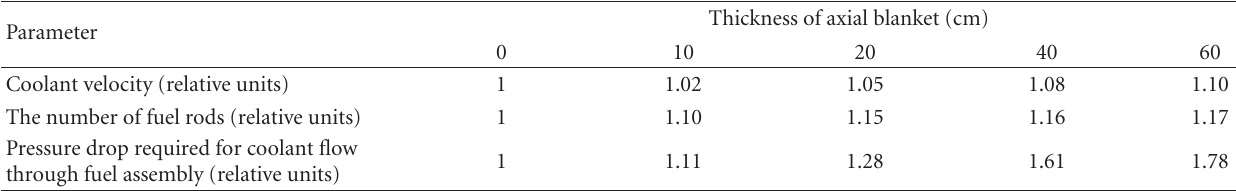
Table 7: Thermal-hydraulic parameters of models with axial